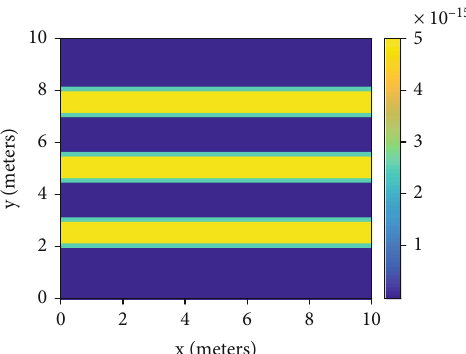
Figure 9: Initial adsorption density in example